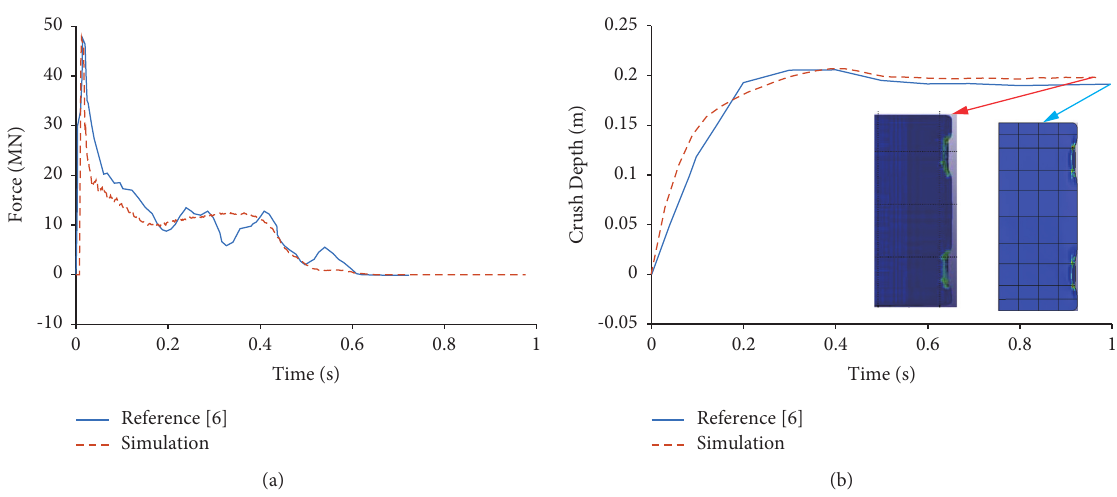
Figure 10: Time history curve of head-on impact at a velocity of 3 m/s: (a) impact force and (b) barge crush